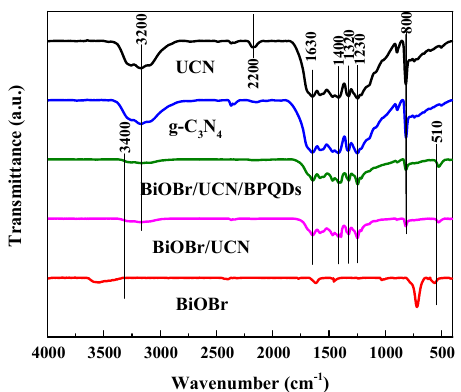
Figure 4. FT-IR analysis of pure g-C 3 N 4 , UCN, pure BiOBr, BiOBr/UCN, and BiOBr/UCN/BPQDs.